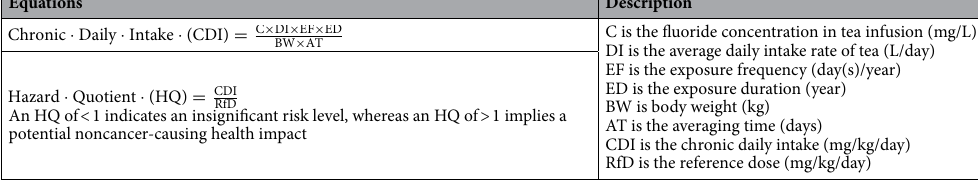
Table 1. Equations used to estimate the Human Exposure and Health Risk 28